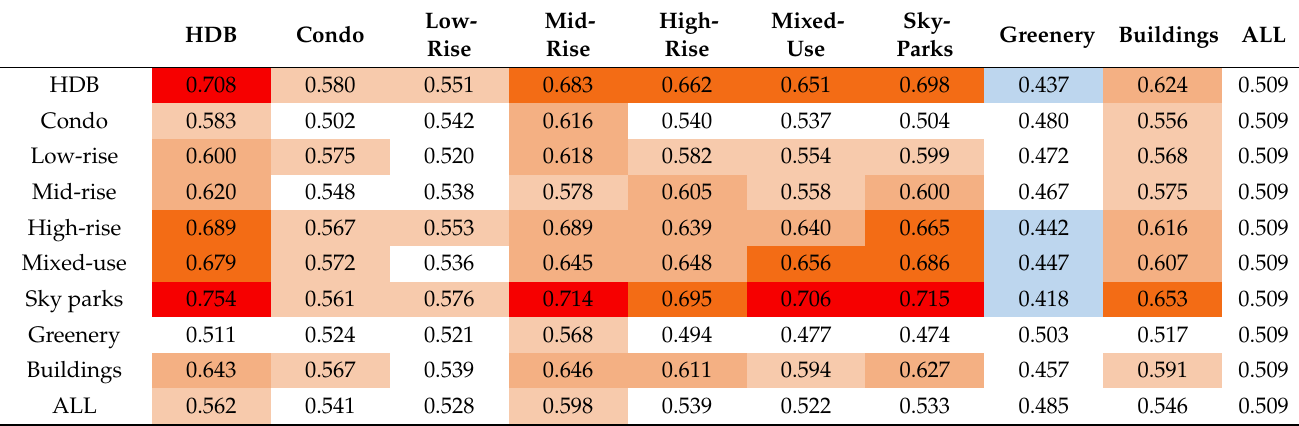
Table 1. Spatial dispersion indices κ ( S , T ) for the different object groups of an individual participant. The rows are the originating object groups ( S ), and the columns indicate the object groups of the nearest neighbors ( T ). Red colored cells indicate high index numbers, blue colored ones low indices.